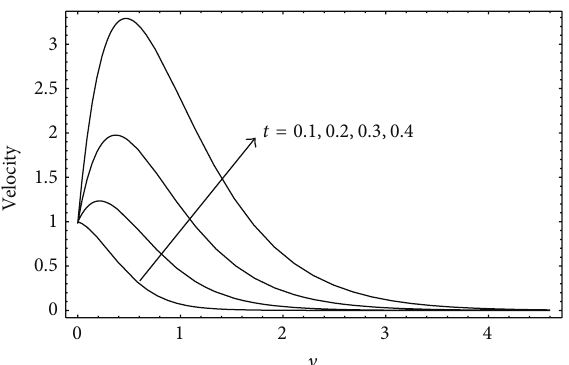
Figure 2: Velocity profiles for different values of 𝑡 when 𝑅 = 2, Pr = 0.71, Gr = 5, Gm = 1, Sc = 0.78, 𝛾 = 1 , and 𝜔 = 𝜋/6 .